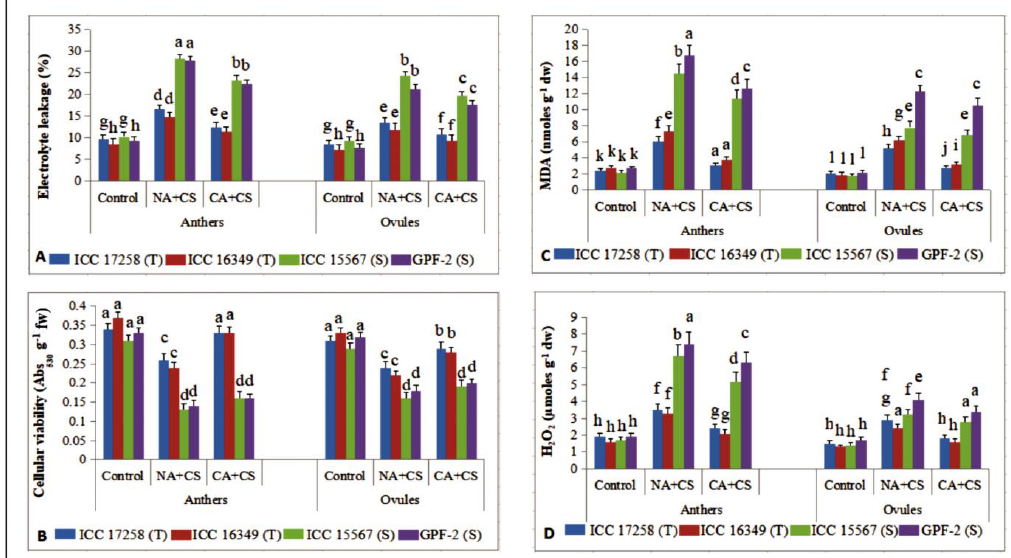
Figure 6. Electrolyte leakage (EL; ( A )), cellular viability (CV; ( B )), (Malondialdehyde (MDA; ( C )) and hydrogen peroxide (H 2 O 2 ; ( D )) concentration in anthers and ovules of control, non-acclimated, cold stressed; NA + CS) and cold-acclimated, cold stressed (CA + CS) plants of tolerant (T) and sensitive (S) genotypes. Small vertical bars represent standard errors (Mean ± S.E; n = 3). Different small letters on vertical bars indicate significant differences from each other ( p < 0.05; Tukey’s test). Least significant difference (LSD) for interaction ( p < 0.05) (genotypes x treatments): EL (2.4), CV (0.067), MDA (1.8), H 2 O 2 (0.23).